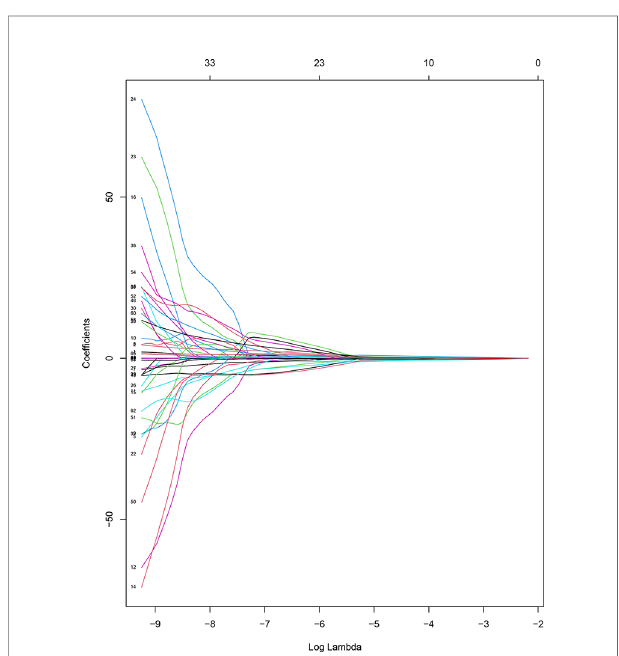
( Figure 4 , 5 ), we obtained the fi nal radiomics features for logistic